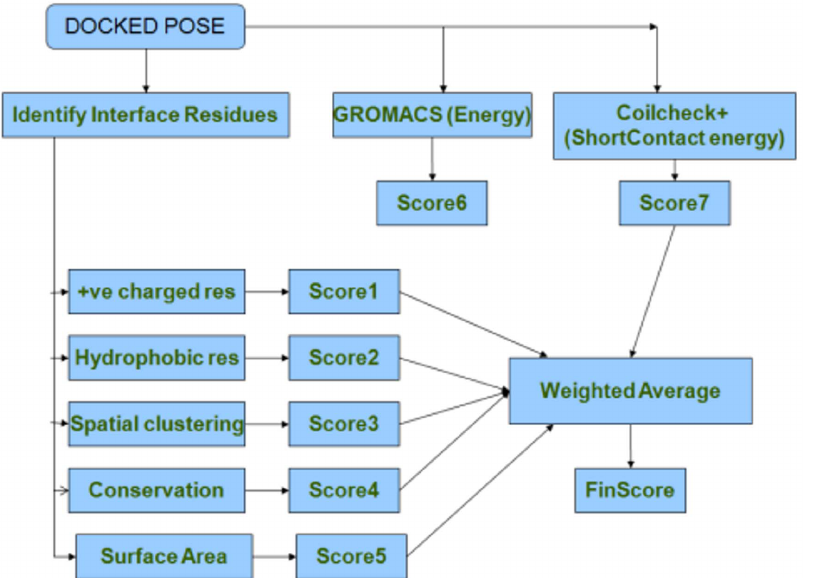
Figure 1. Workflow of DockScore. Interface residues are identified and several structural parameters are taken into account to record the scoring. The final score obtained is the weighted score and weights are assigned by testing the performance. FinScore is the final DockScore obtained using the weighted average.